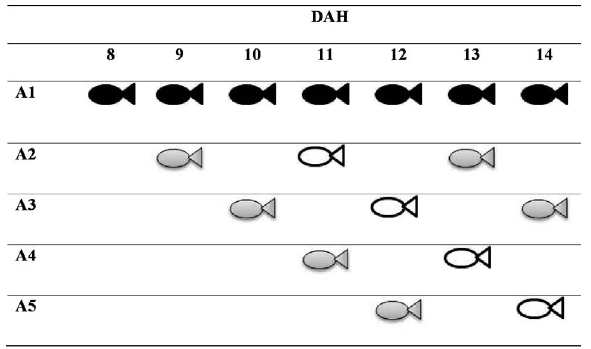
Fig . 1. – Experimental design illustrating which aquarium (A1 to A5) supplied larvae to which feeding treatment and which ages. Black fishes represent larvae from the ad libitum treatment, grey fishes represent larvae from the short starvation treatment, and white fishes represent larvae from the long starvation